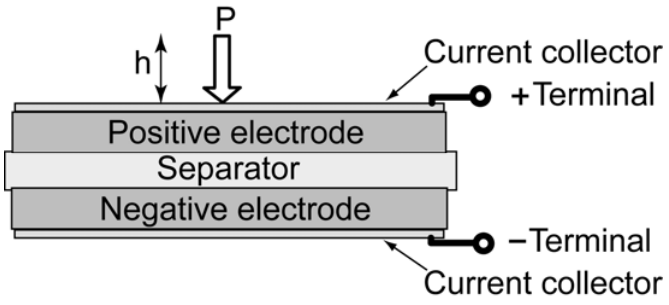
Figure 2. Schematic of the linear actuators.